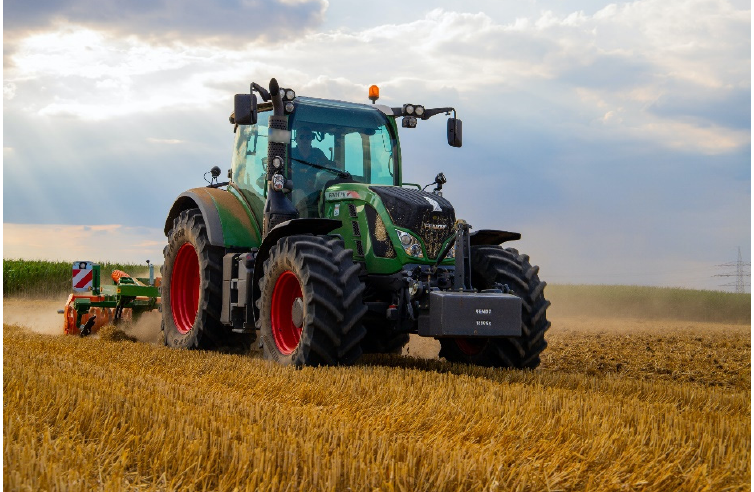
Figure 8. Agricultural tractor. Series hybrid concept for this type of equipment was presented in [71] with electric drivetrain and PTO.